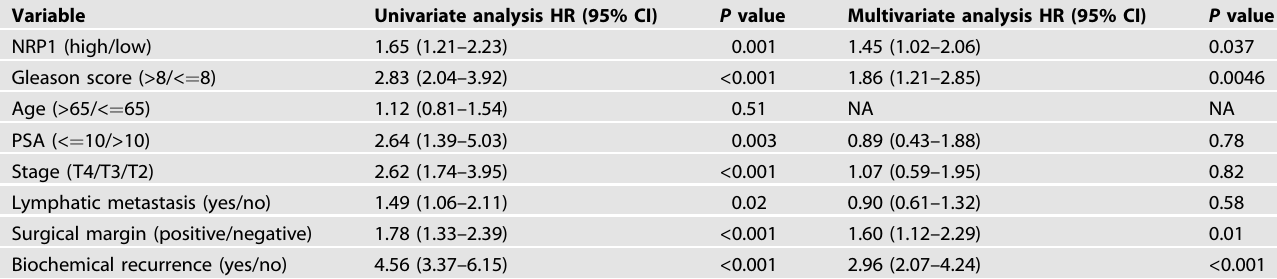
Table 2. Univariate and multivariate analyses of risk factors for disease-free survival of prostate cancer.